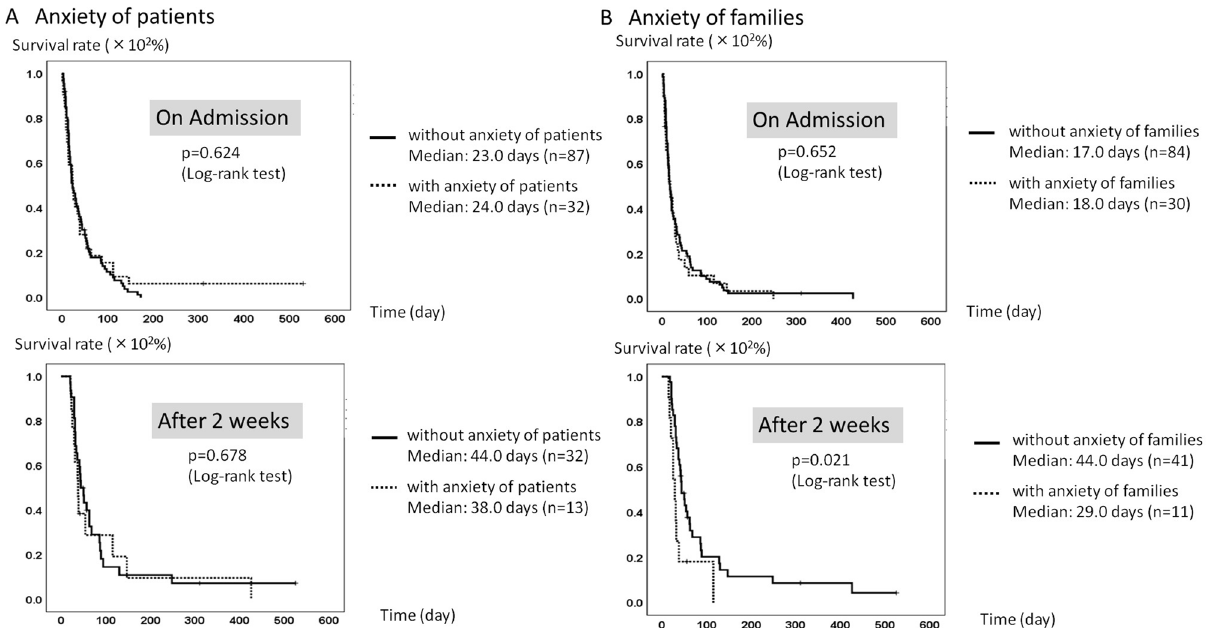
Figure 2. Patient survival and anxiety. ( A ) Anxiety of patients. No significant relation was found between patient survival and anxiety of patients on admission and after 2 weeks of admission: p = 0.624 and 0.678 respectively. Higher anxiety is defined as STAS-J: anxiety ≥ 2. ( B ) Anxiety of families. On admission, no significant difference was found in survival time between groups with and without higher anxiety of families defined as STAS-J anxiety ≥ 2: with, median 18.0 days, n = 30; without, median 17.0 days, n = 84; p = 0.652. However, significantly shorter survival was found when anxiety of family members was higher after 2 weeks: with higher anxiety, median 29.0 days, n = 11; without, median 44.0 days, n = 41; p =